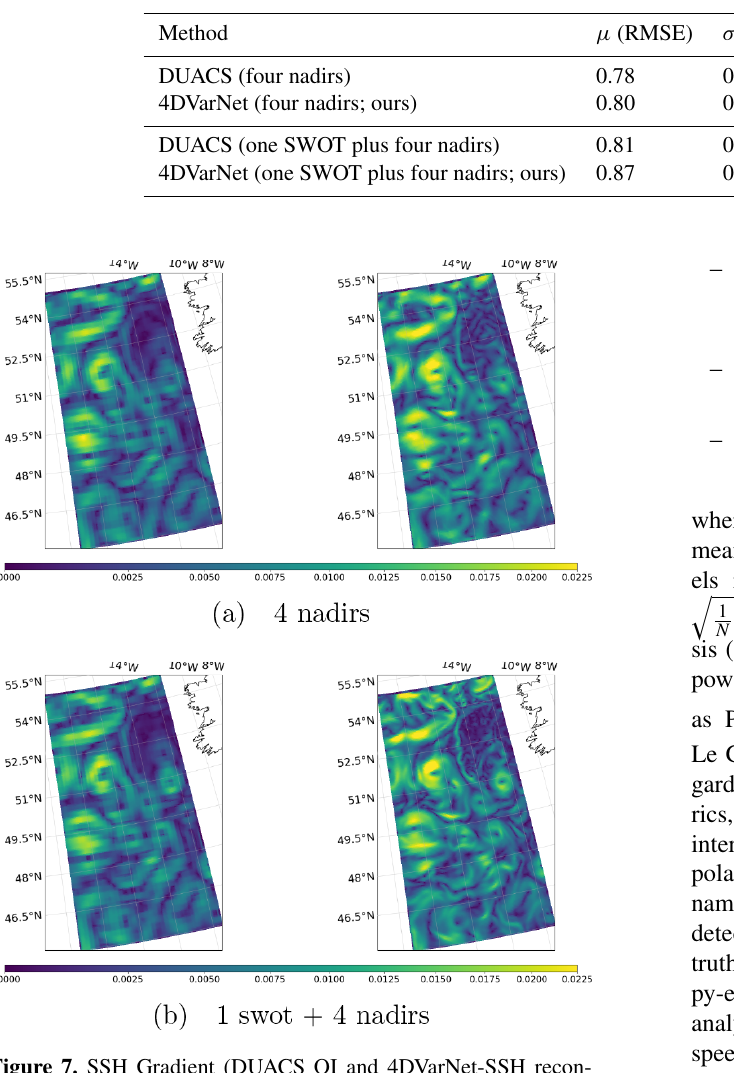
Table 3. 4DVarNet-SSH performance on the OSMOSIS domain compared to DUACS OI over the period from 22 October to 2 Decem- ber 2012 (42d). Bold formatting stands for the best metrics.